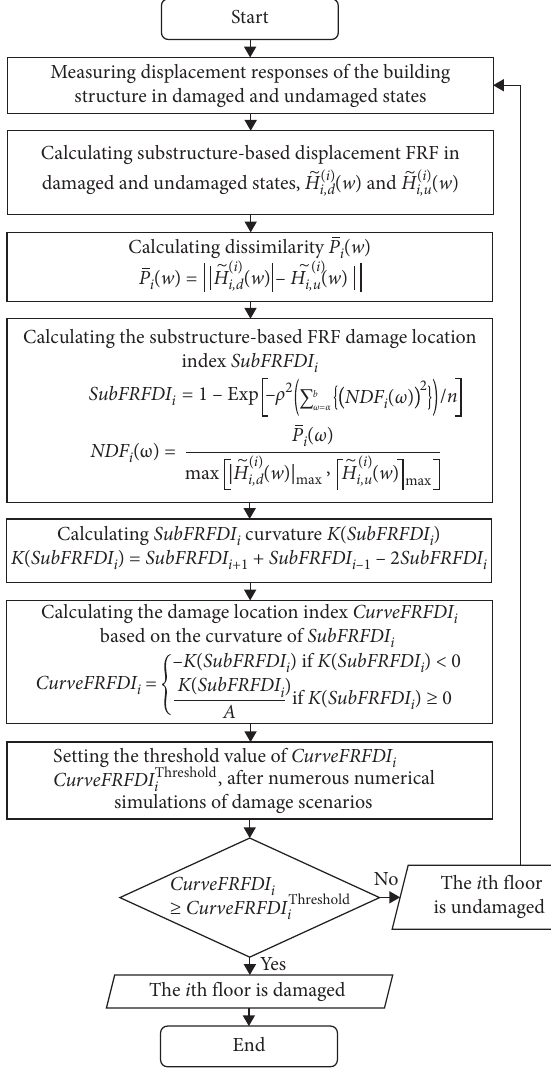
Figure 2: The flowchart of the proposed damage location